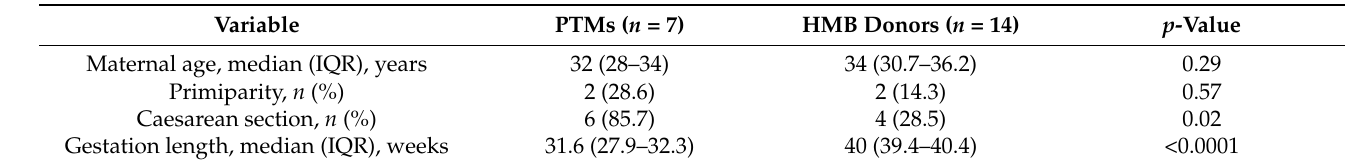
Table 1. The clinical and demographic characteristics of mothers who delivered prematurely and mothers recruited as HM